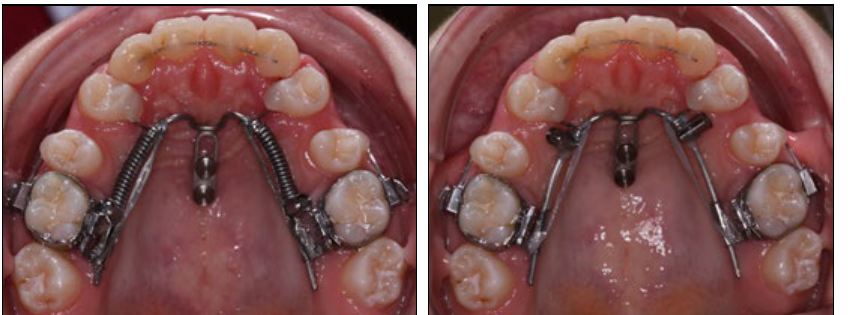
Figure 8. Midstage intraoral photographs recorded six months into treatment.